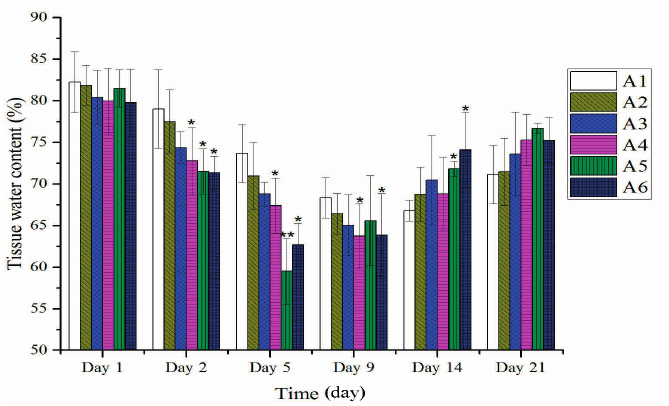
Figure 1. Effect of different concentration or fractions of BBO on the tissue water content in rats. Values are expressed as mean ± S.D. ( n = 4 animals). * : p < 0.05 vs. control; ** : p < 0.01 vs. control.